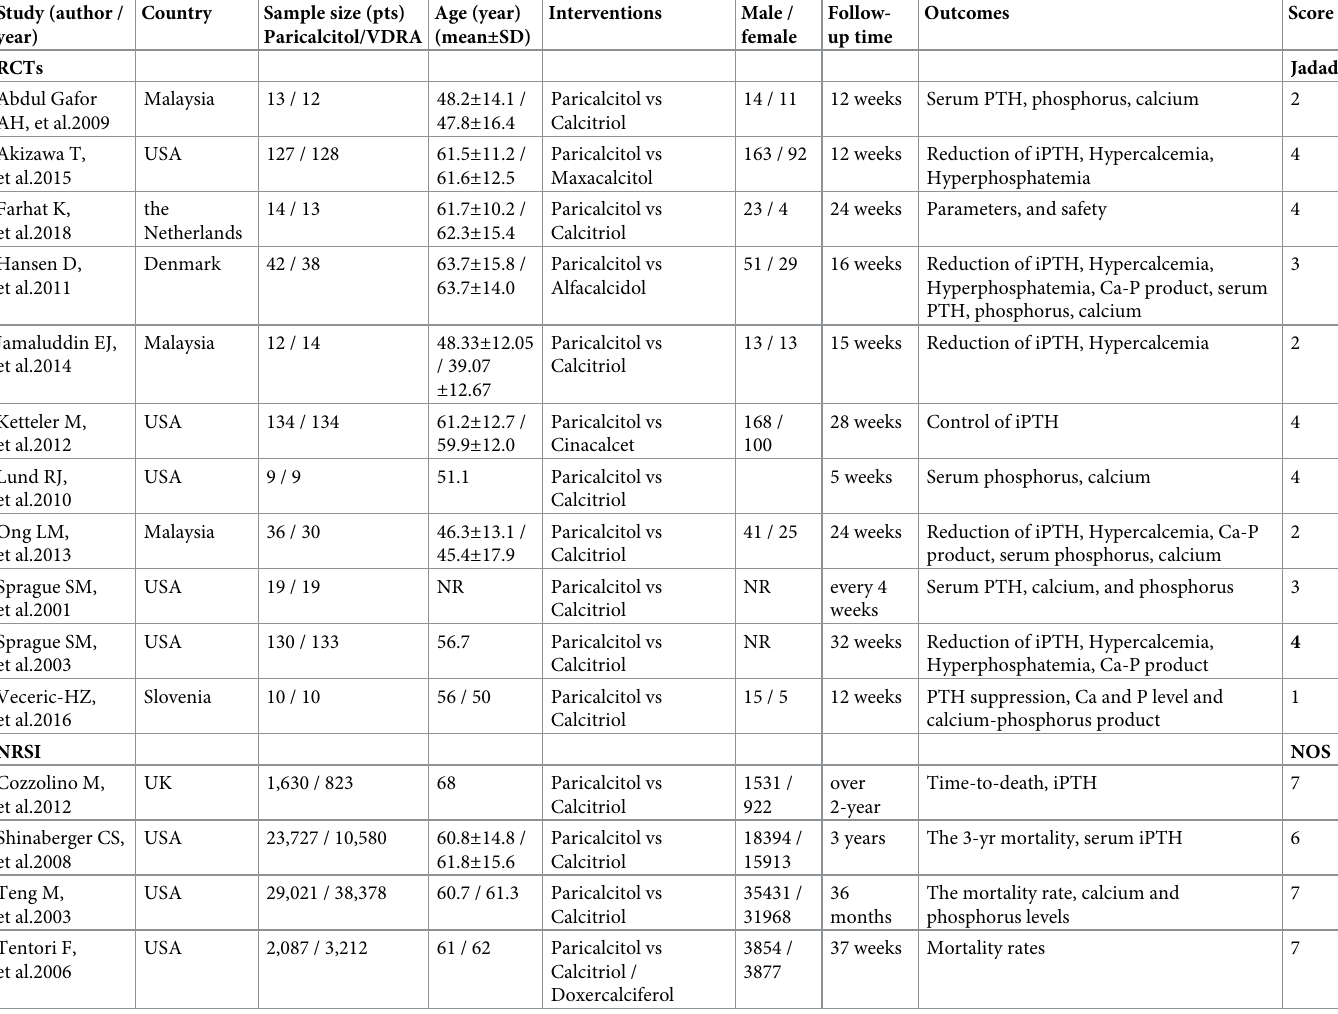
Table 1. The characteristics of included studies for the present systematic review and